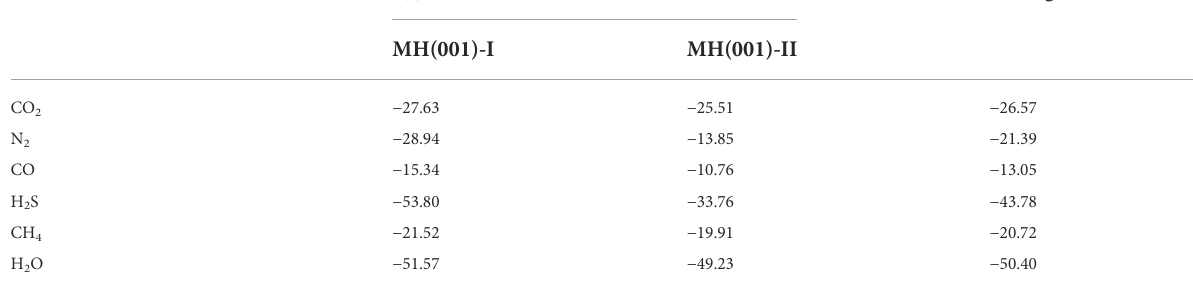
TABLE 5 Calculated adsorption energies ( E ad ) of CO 2 , N 2 , CO, H 2 S, CH 4 , and H 2 O onto MH(001)-I and MH(001)-II substrates. Adsorbed